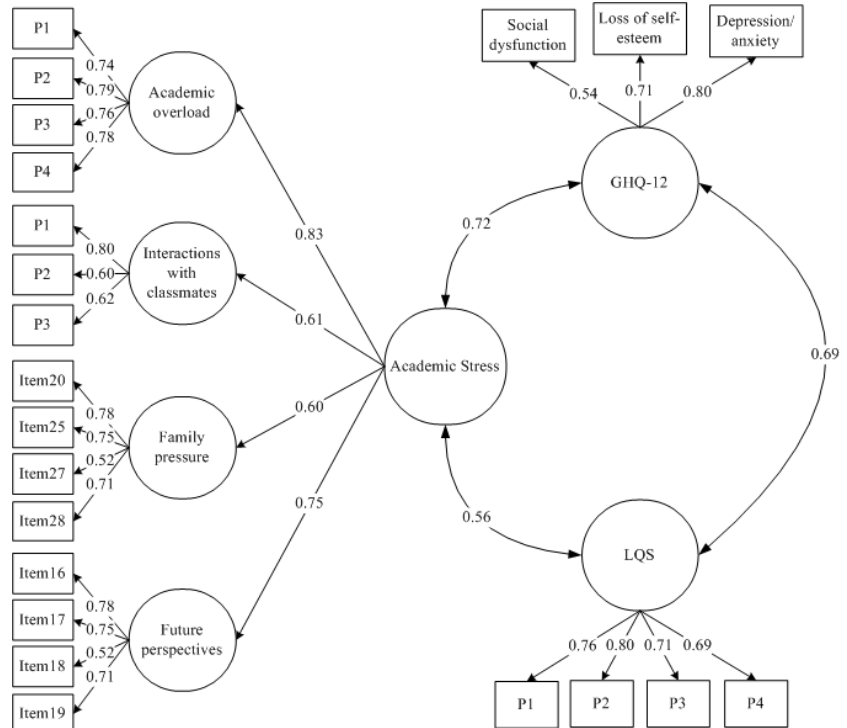
Figure 2. Confirmatory factor model relating QASSE, General Health Questionnaire 12-items (GHQ-12), and List of Somatic Complaints (LQS).